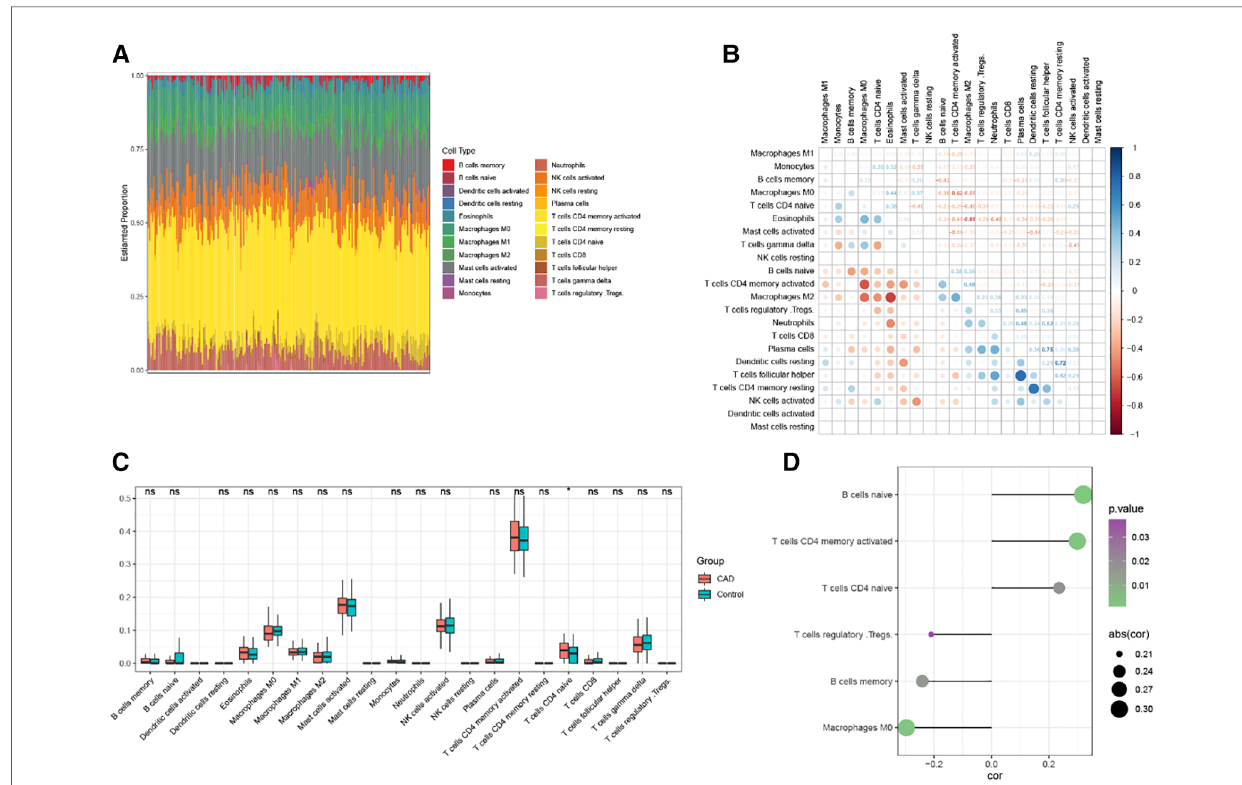
FIGURE 7 Analysis of CAD immune in fi ltration. ( A ) Each sample ’ s 22 immunological cells as a percentage. ( B ) Correlation analysis of 22 immune cells. ( C ) 22 immune cells ’ expression levels differ between CAD and Control. ( D ) Correlation analysis of RBP1 and immune